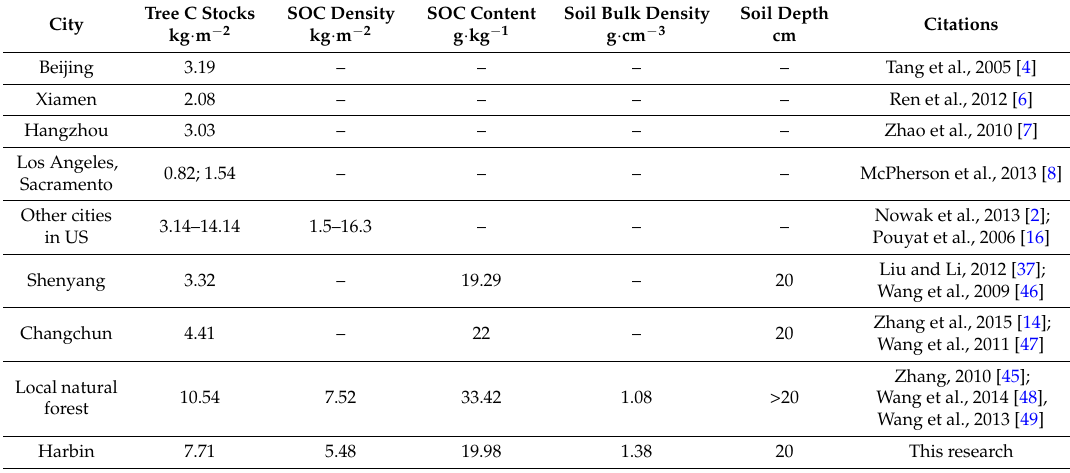
Table 2. Tree C stock density, soil organic carbon (SOC) density, SOC content, and soil bulk density in Harbin City compared with other cities and local natural forests.